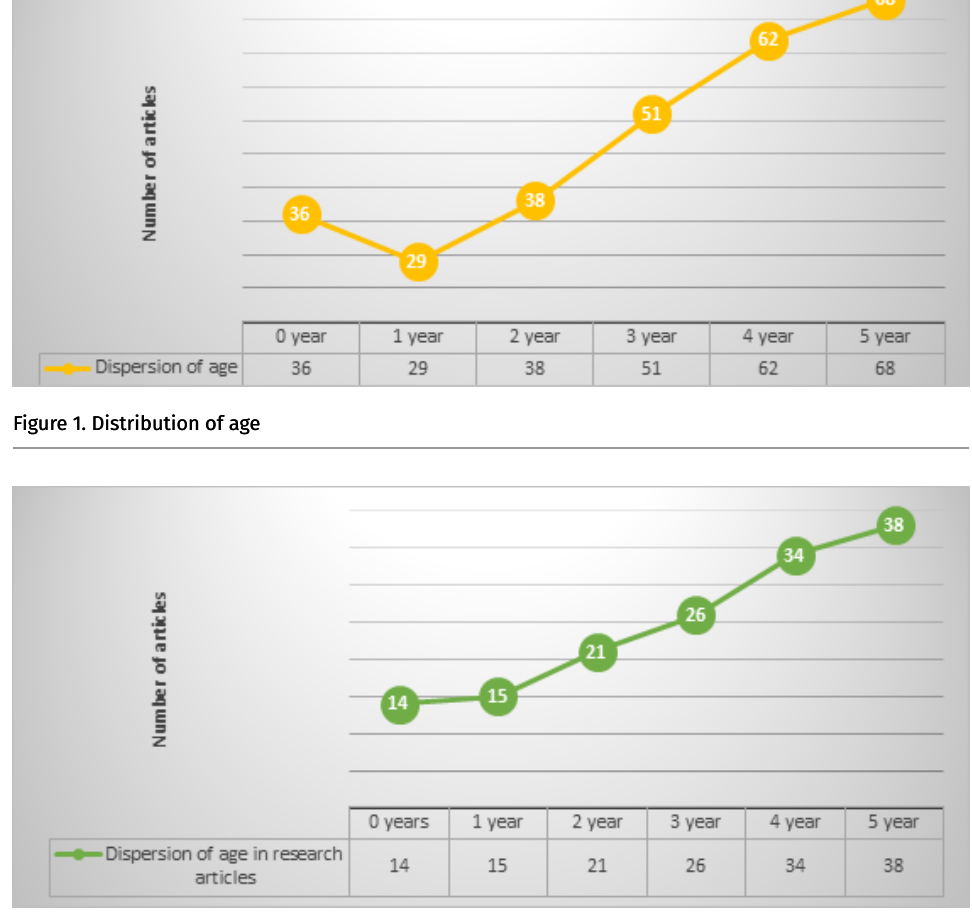
FFigigururee 2.2. DistributionDistribution ofof aaggee inin rreseeseararchch